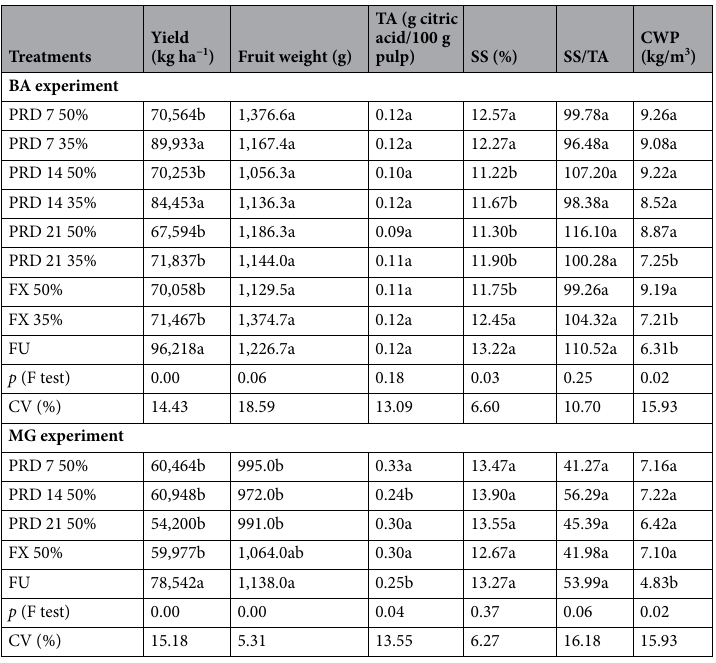
Table 4. Mean yield, mean weight, titratable acidity (TA), soluble solids (SS), SS/TA ratio of fruits and crop water productivity (CWP) of papaya cultivated under PRD: with alternation at 7, 14 and 21 days; FX: fixed irrigation on one side of the rootzone; and FU: full irrigation, in Bom Jesus da Lapa-BA and Jaíba-MG. Means followed by the same letter in the column do not differ statistically by Scott-Knott test at 5% probability level.